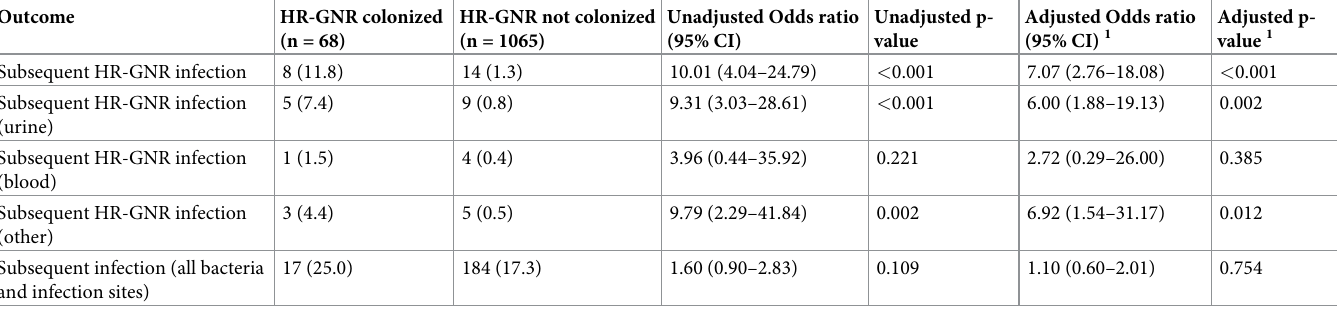
Table 3. Association between HR-GNR colonization and subsequent HR-GNR